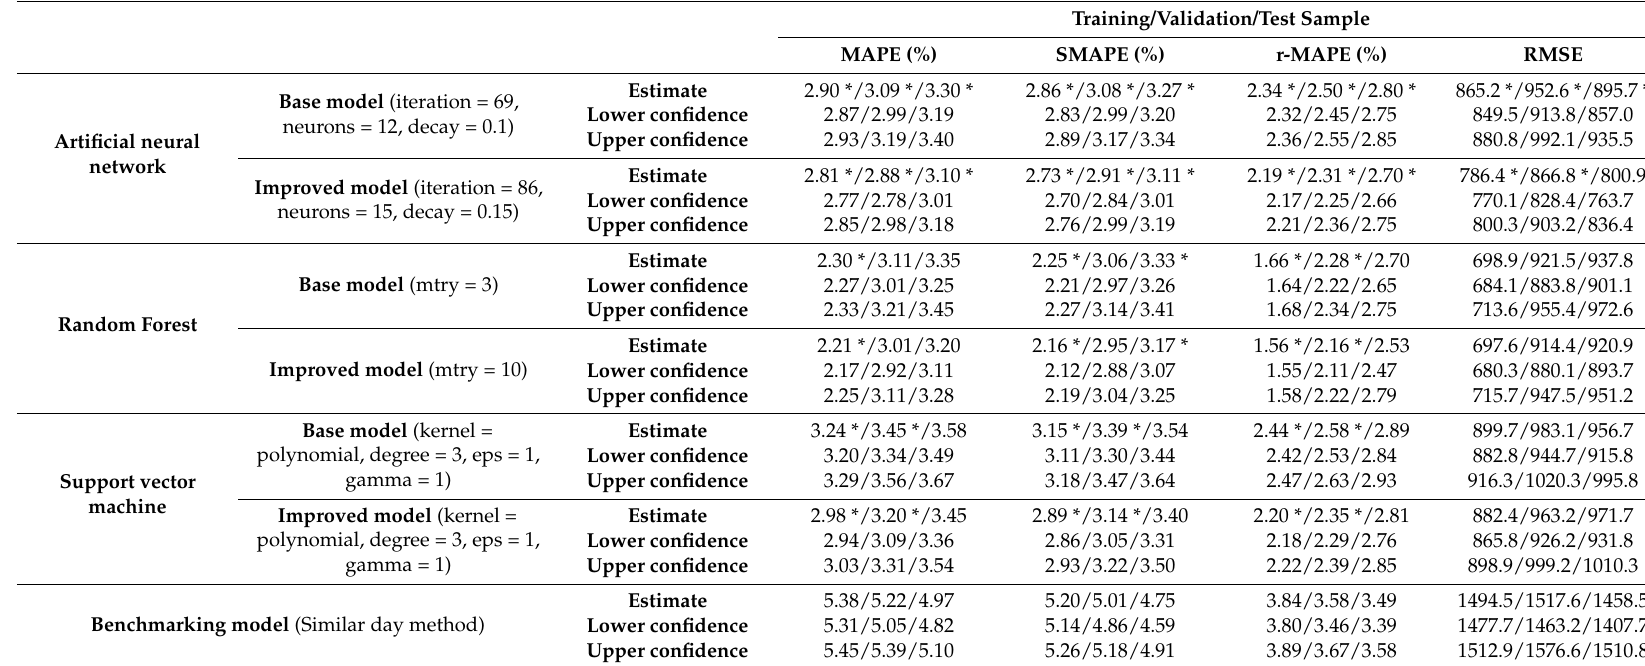
Table 9. Forecasting results of the machine learning